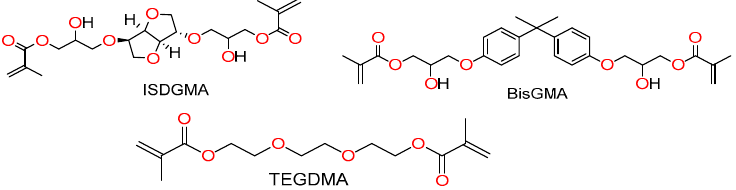
Figure 3. ISDGMA (1,4:3,6-dianhydro- D -sorbitol 2,5-bis(2-hydroxy-3-methacylolxypropoxy)), Bis- GMA (2,2-bis [4-(2-hydroxy-3-methacryloyloxypropoxy)phenyl] propane), and TEGDMA (triethy- lene glycol dimethacrylate).